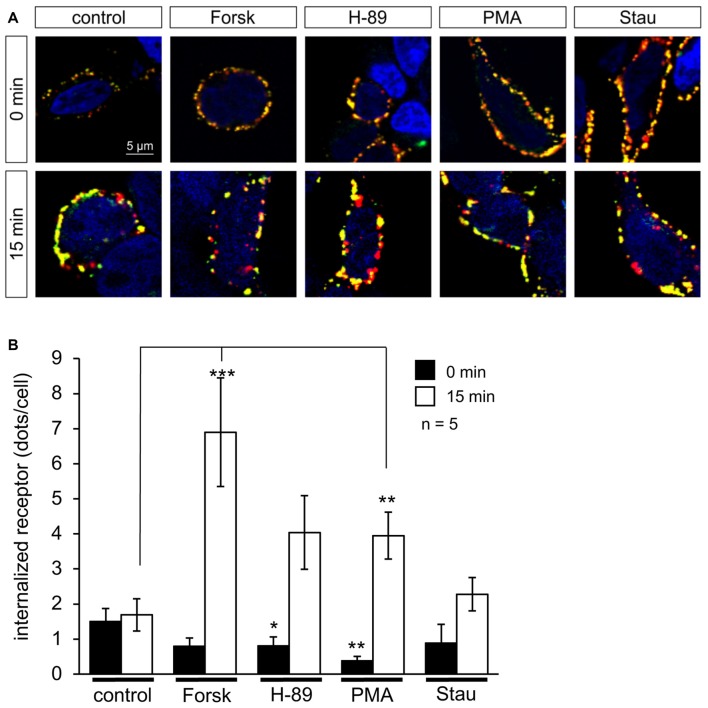
PKA and C activators enhance GlyR internalization. HEK293 cells transfected with GlyRα1-β were pre-labeled with the specific α1 antibody MAb2b and goat-anti-mouse Cy3-coupled secondary antibody, followed by incubation with PKA activator Forskolin (Forsk), PKA inhibitor H-89, PKC activator PMA and PKC inhibitor Staurosporine aglycon (Stau) for 0 min and 15 min in cell culture medium at 37°C and 5% CO2. Retained receptors at the surface were double labeled using a donkey-anti-goat-Dyelight488 antibody. (A) Representative cells at various time points (0, 15 min) incubated with PKA and PKC activators and inhibitors showing internalized receptor (red dots), and receptor retained at the cellular surface (yellow dots), control always shows untreated cell (UT). White arrows point to internalized receptors. Nuclei (blue) were marked by 4′,6-diamidino-2-phenylindole (DAPI). (B) Quantification of internalized receptor (red dots/cell) at two different time points (0 min = black bars; 15 min = white bars). Averages from five independent experiments ± SEM are given, determined from 16 to 51 cells per condition. Significance values (one-way ANOVA) *p < 0.05, **p < 0.01, ***p < 0.001.